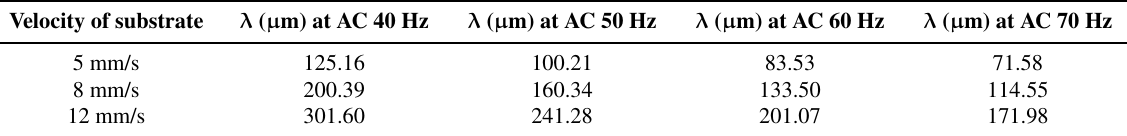
Table 1. The wavelength ( λ ) of serpentine structures deposited with different frequency of the AC voltage and different velocity of substrate. The values correspond to the mean wavelength of each serpentine pattern by measuring every ten